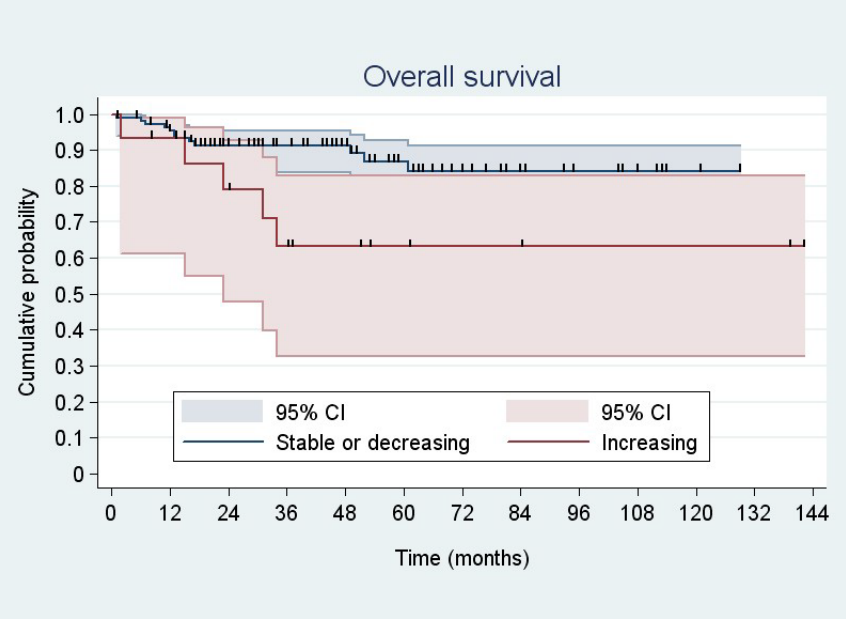
Kaplan-Meier analysis of overall survival after stratification for serological progression prior to PC-RPLND. Stable or decreasing overall survival at 5 years 87% (95% CI: 76–93%); Increasing overall survival at 5 years 63% (95% CI: 33–83%), p = 0.028 for